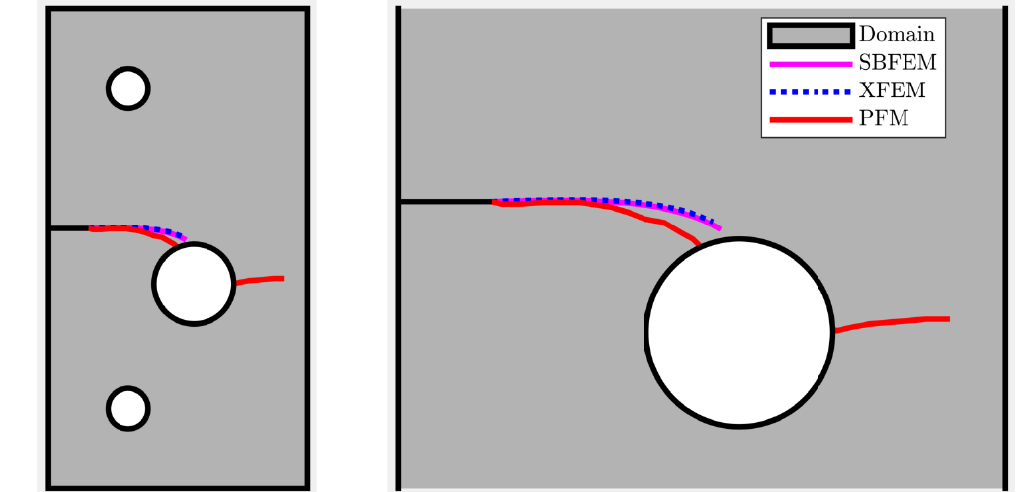
Figure 25. NPwH crack-paths obtained from SBFEM, XFEM and PFM-based crack propagation